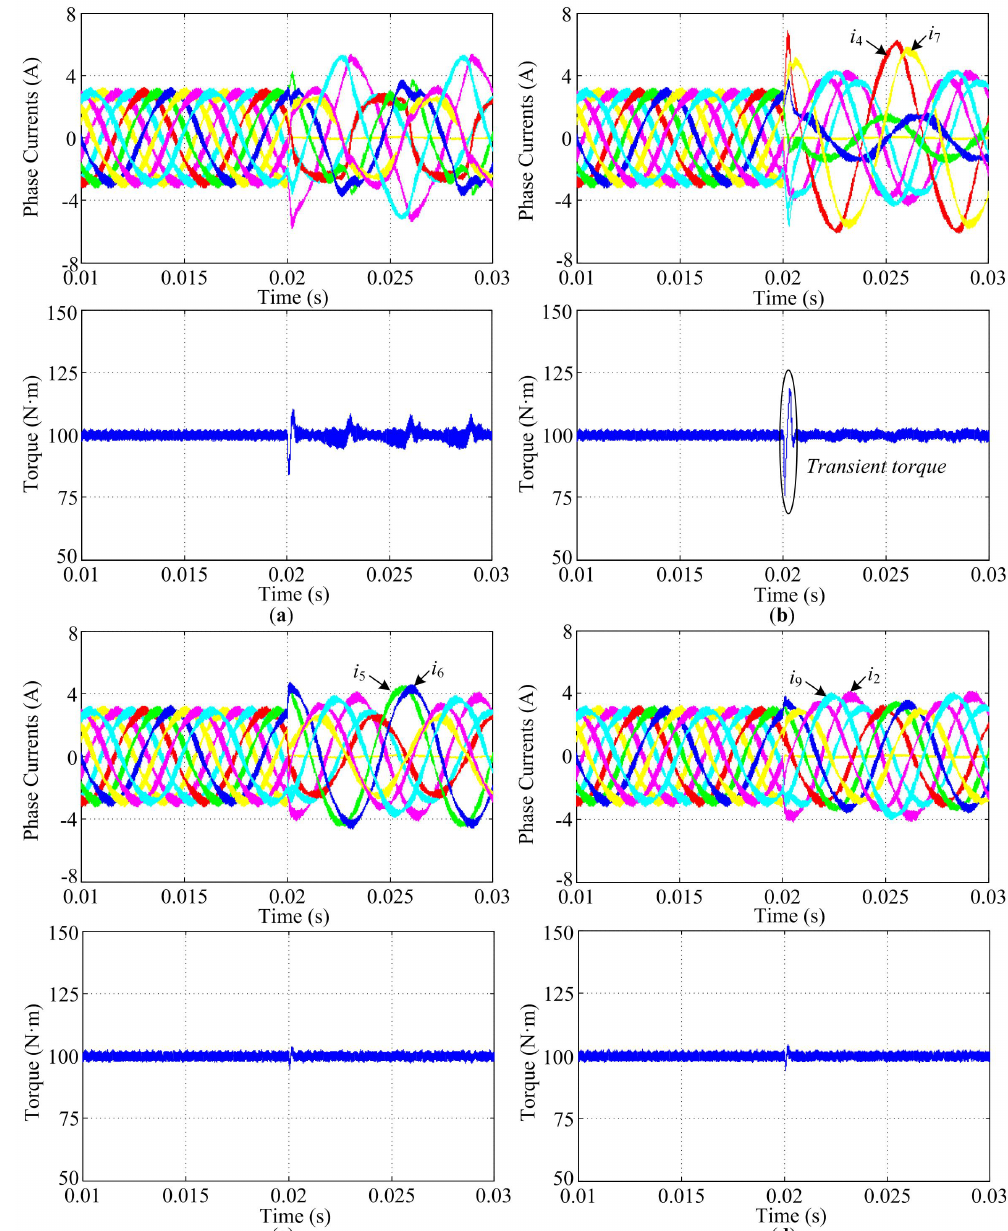
Figure 11. Simulation evaluation of post-fault operation. ( a ) Faulty operation; ( b ) Minor Reconstruction; ( c ) Mid Reconstruction; ( d ) Max